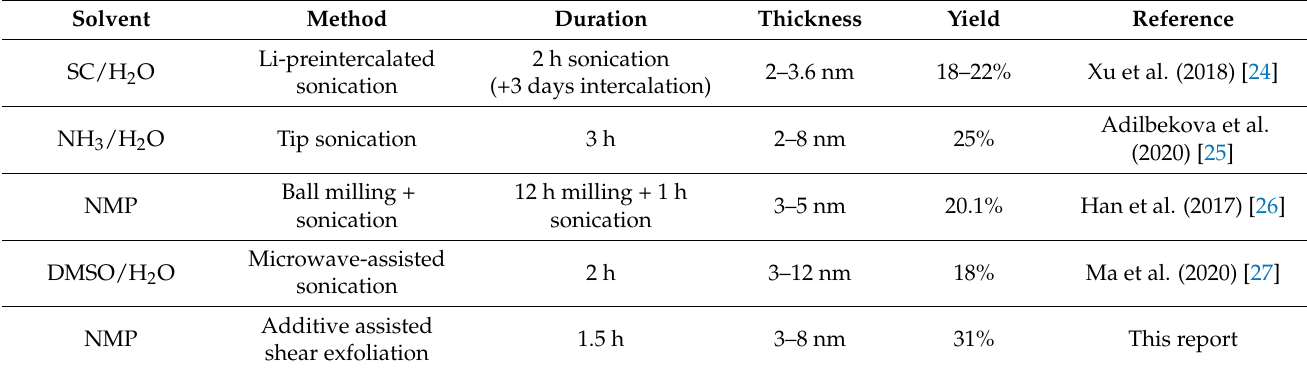
Figure 2. Optical characterization of AAE results: ( a ) photograph of conventional exfoliation and AAE solutions after exfoliation, ( b ) UV-visible absorption spectra of AAE and conventional solutions after 1.2 krpm centrifugation with indication of A-exciton peak at 640 nm, ( c ) schematic of liquid cascade centrifugation stages and ( d ) corresponding photographs of AAE and conventionally exfoliated solutions. Table 1. Comparison of WS 2 yield and thickness for different exfoliation